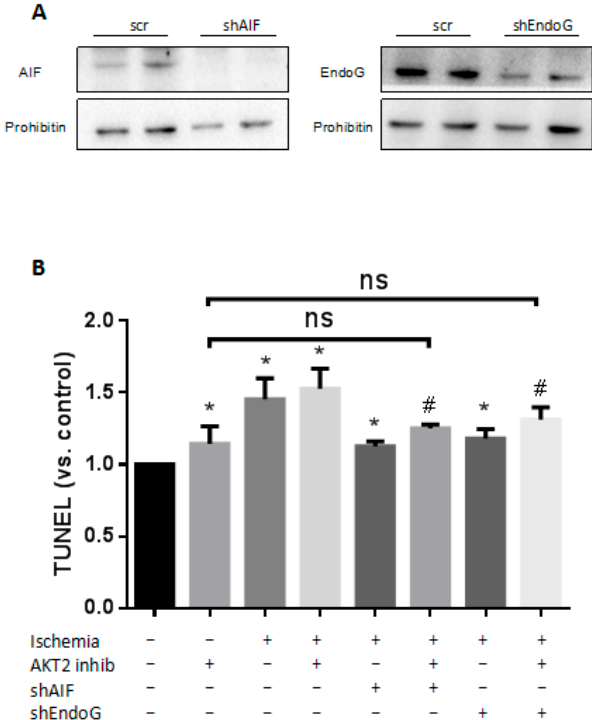
Figure 6. Ischemia induces mitochondrial injury and mitochondrial protein translocation in cardiomyocytes. ( A ) Expression of AIF and EndoG in 40 μ g of protein from total extracts of cardiomyocytes transduced, scrambled (scr), and transduced with AIF-specific and EndoG-specific small hairpin RNA interference (shRNAi) construct (shAIF and shEndoG), 5-days post infection. Prohibitin was used as loading control; ( B ) Detection of apoptosis by TUNEL in scrambled-transduced (scr), EndoG-deficient (shEndoG), and AIF-deficient (shAIF) cardiomyocytes test for post hoc analyses). ns: not